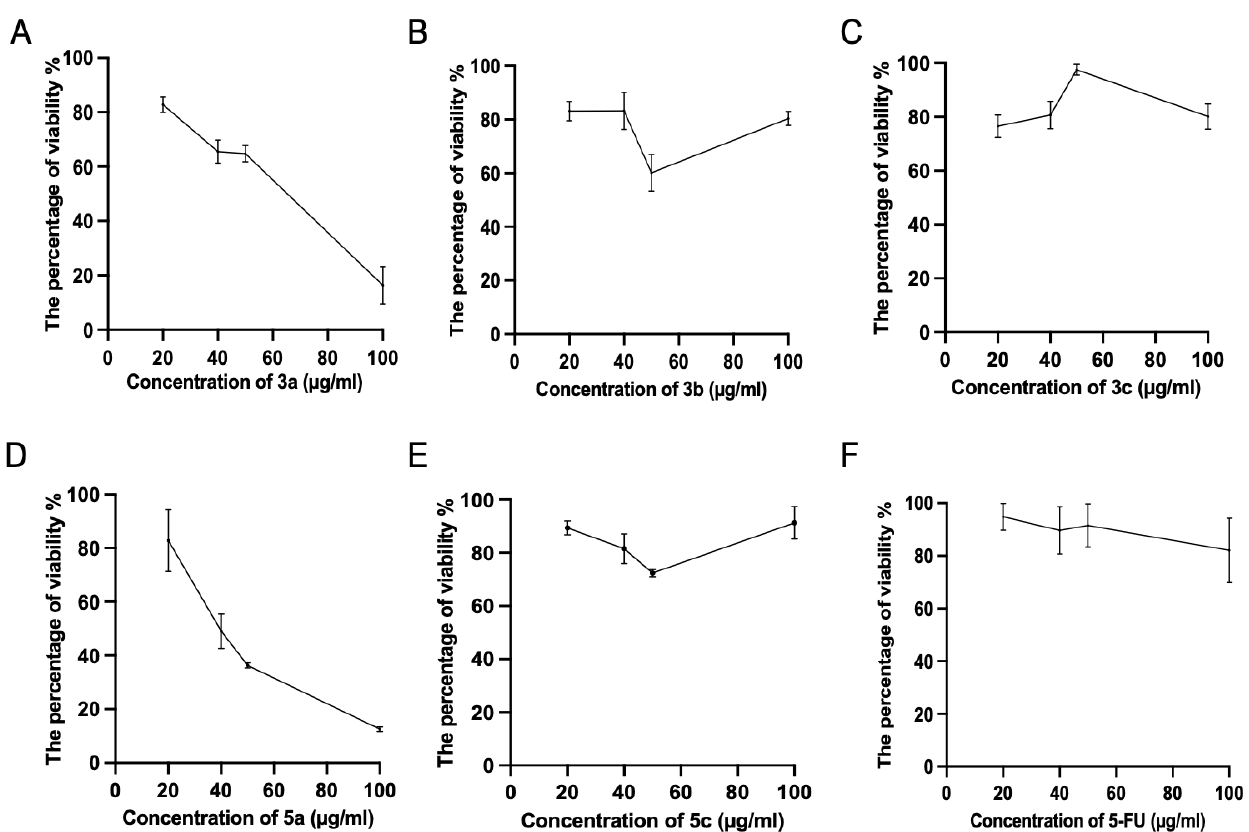
Figure 2. Cytotoxic evaluations of the tested chalcone compounds against the Luc-4T1 cell line. The cell line was treated for 48 h with different concentrations (20, 40, 50, and 100 μg/mL) of the individual chalcones: ( A ) compound 3a , ( B ) compound 3b , ( C ) compound 3c , ( D ) compound 5a , ( E ) compound 5c , and ( F ) 5-FU , and the percentage of viability was determined through MTT assay. The values are means ± SD ( n = 4), and two independent experiments were examined.